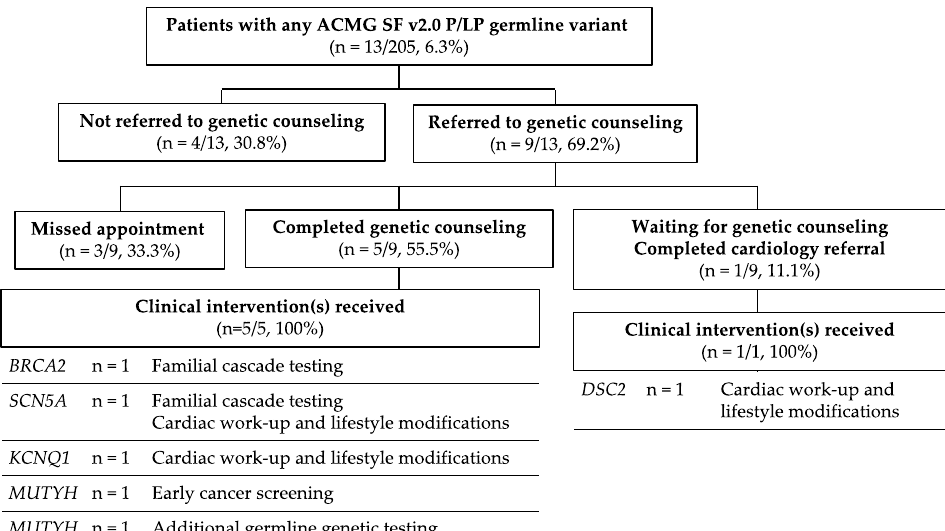
Figure 2. Clinical follow up for hereditary disease predisposition